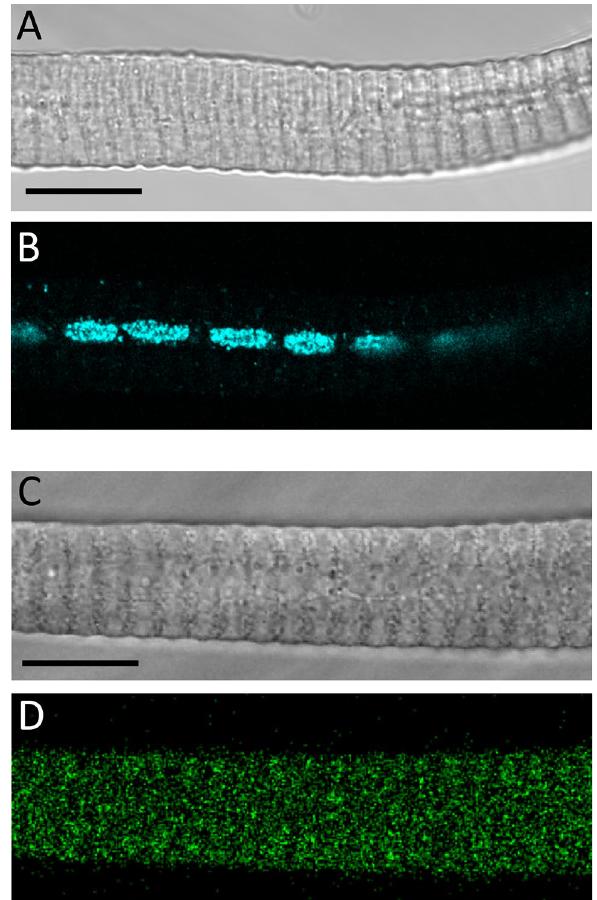
Figure 1. General structure of bee muscle fibres. ( A) Transmitted light for a honey bee tibia muscle fibre (mean sarcomere length 4,9 µm). ( B ) Confocal longitudinal section through the fluorescent central row of nuclei labelled with Hoechst stain (same fibre as in A). ( C ) Transmitted light for a Fluo-8 stained fibre (mean sarcomere length 4,4 µm). ( D ) Confocal fluorescence image of the fibre shown in C. Scale bars = 20